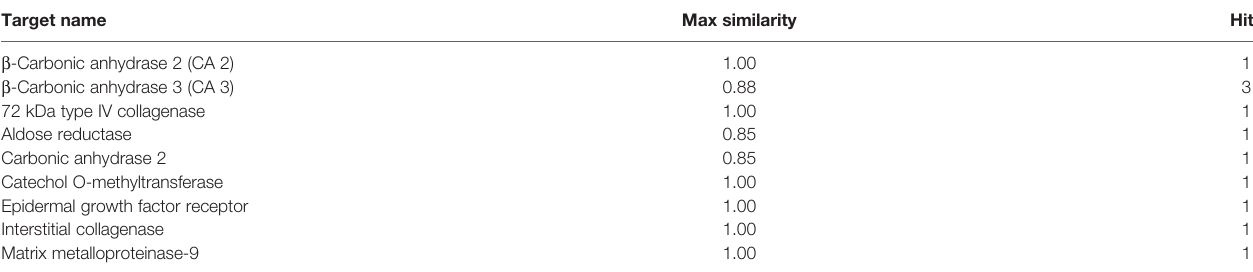
TABLE 2 | List of enzyme inhibition constant data from Binding DB for compound caffeic acid similarity at least >0.85. Target name